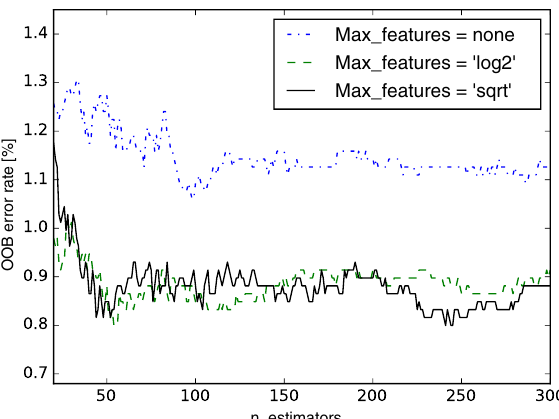
Figure B1. Out-of-bag error for different values of n_estimators (number of trees) for three different realizations of the random for- est classifier by changing the number of features considered at each